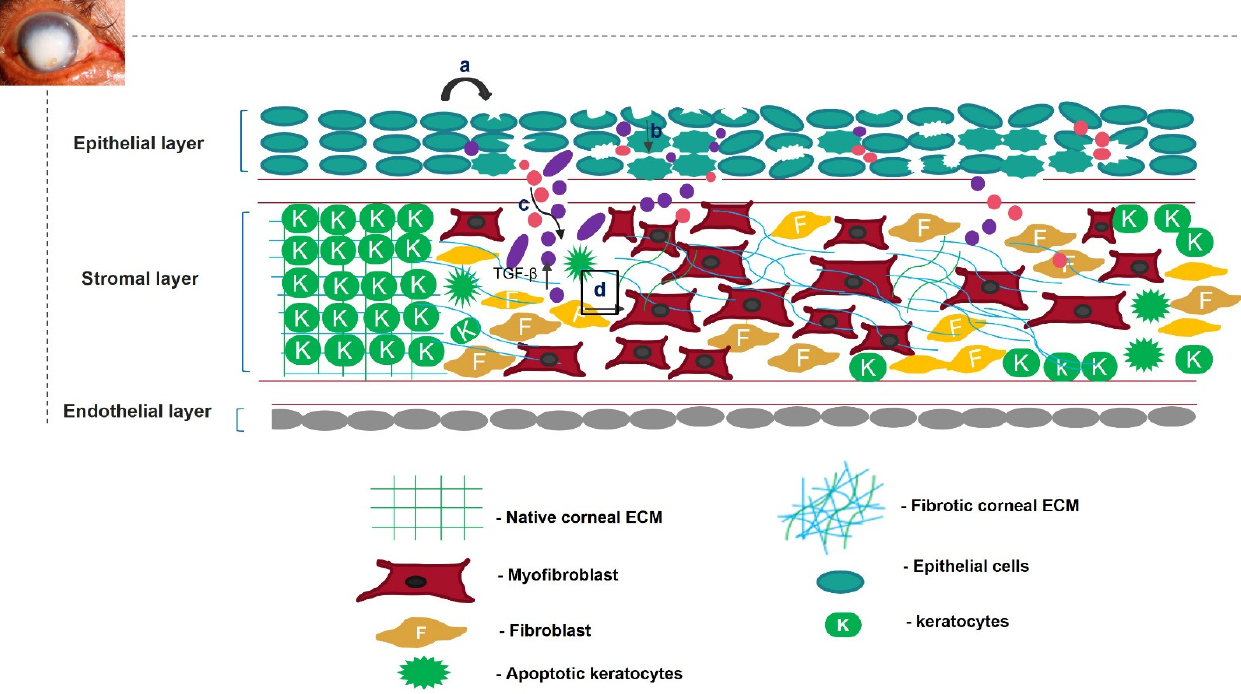
Figure 1. Overview of corneal wound-healing process and scar formation. After an ocular wound, specifically epithelial wounding, ( a ) the epithelial cells undergo apoptosis, ( b ) and epithelial cell markers are lost because of corneal epithelial injury, triggering their migration and proliferation. A deep injury disrupts Bowman’s membrane, allowing the invasion of neutrophils (pink) and macrophages (purple) into the stromal layer and releasing TGF- β . This increases the concentration of TGF- β in the stromal layer ( c ). Therefore, the keratocytes undergo apoptosis, differentiate into myofibroblasts, and disrupt the arrangement of the corneal ECM ( d